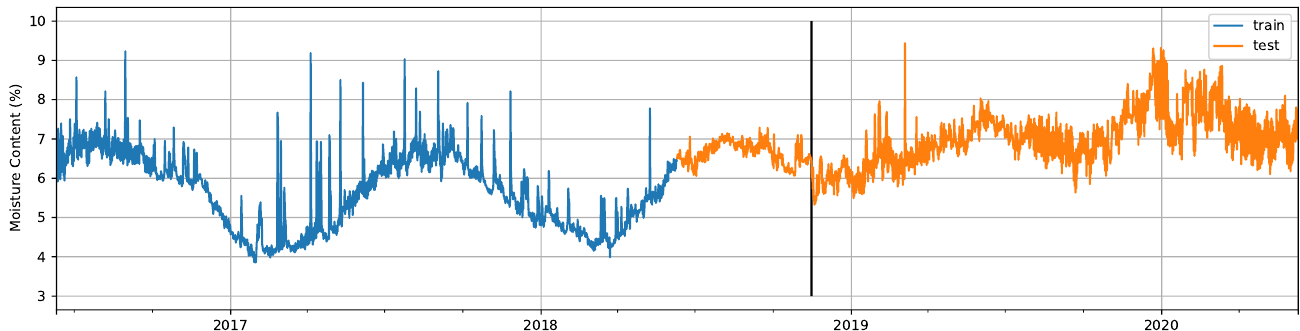
Figure 5. Training and test splits of one of the 4 signals that composes the windows dataset, with the date on which the failure occurred marked with a vertical black